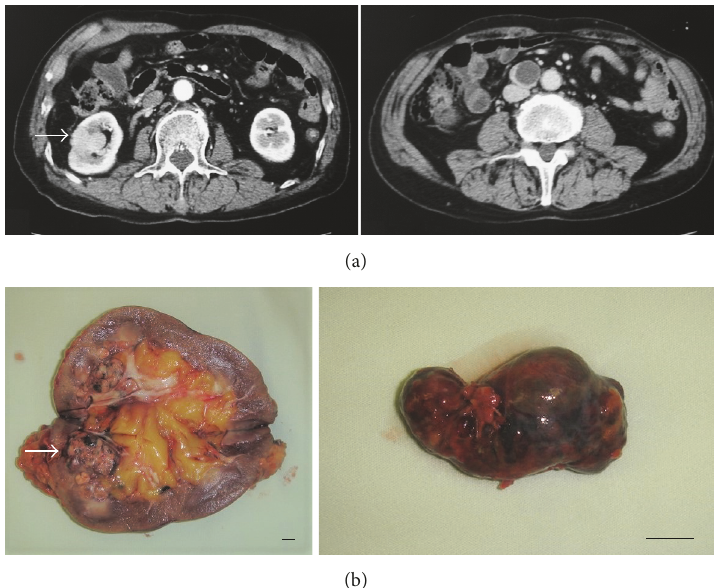
Figure 1: (a) Enhanced CT of the abdomen showing a nonexophytic and hypervascular tumor (arrow) in the right kidney (left) and a cystic lymph node in the aortocaval area (right). (b) Macroscopic findings of the resected specimens showing an ash-colored, tessellated, and fibrous capsuled renal tumor (arrow) in the right kidney (left) and a tense and cystic lymph node (right); bars, 1cm.